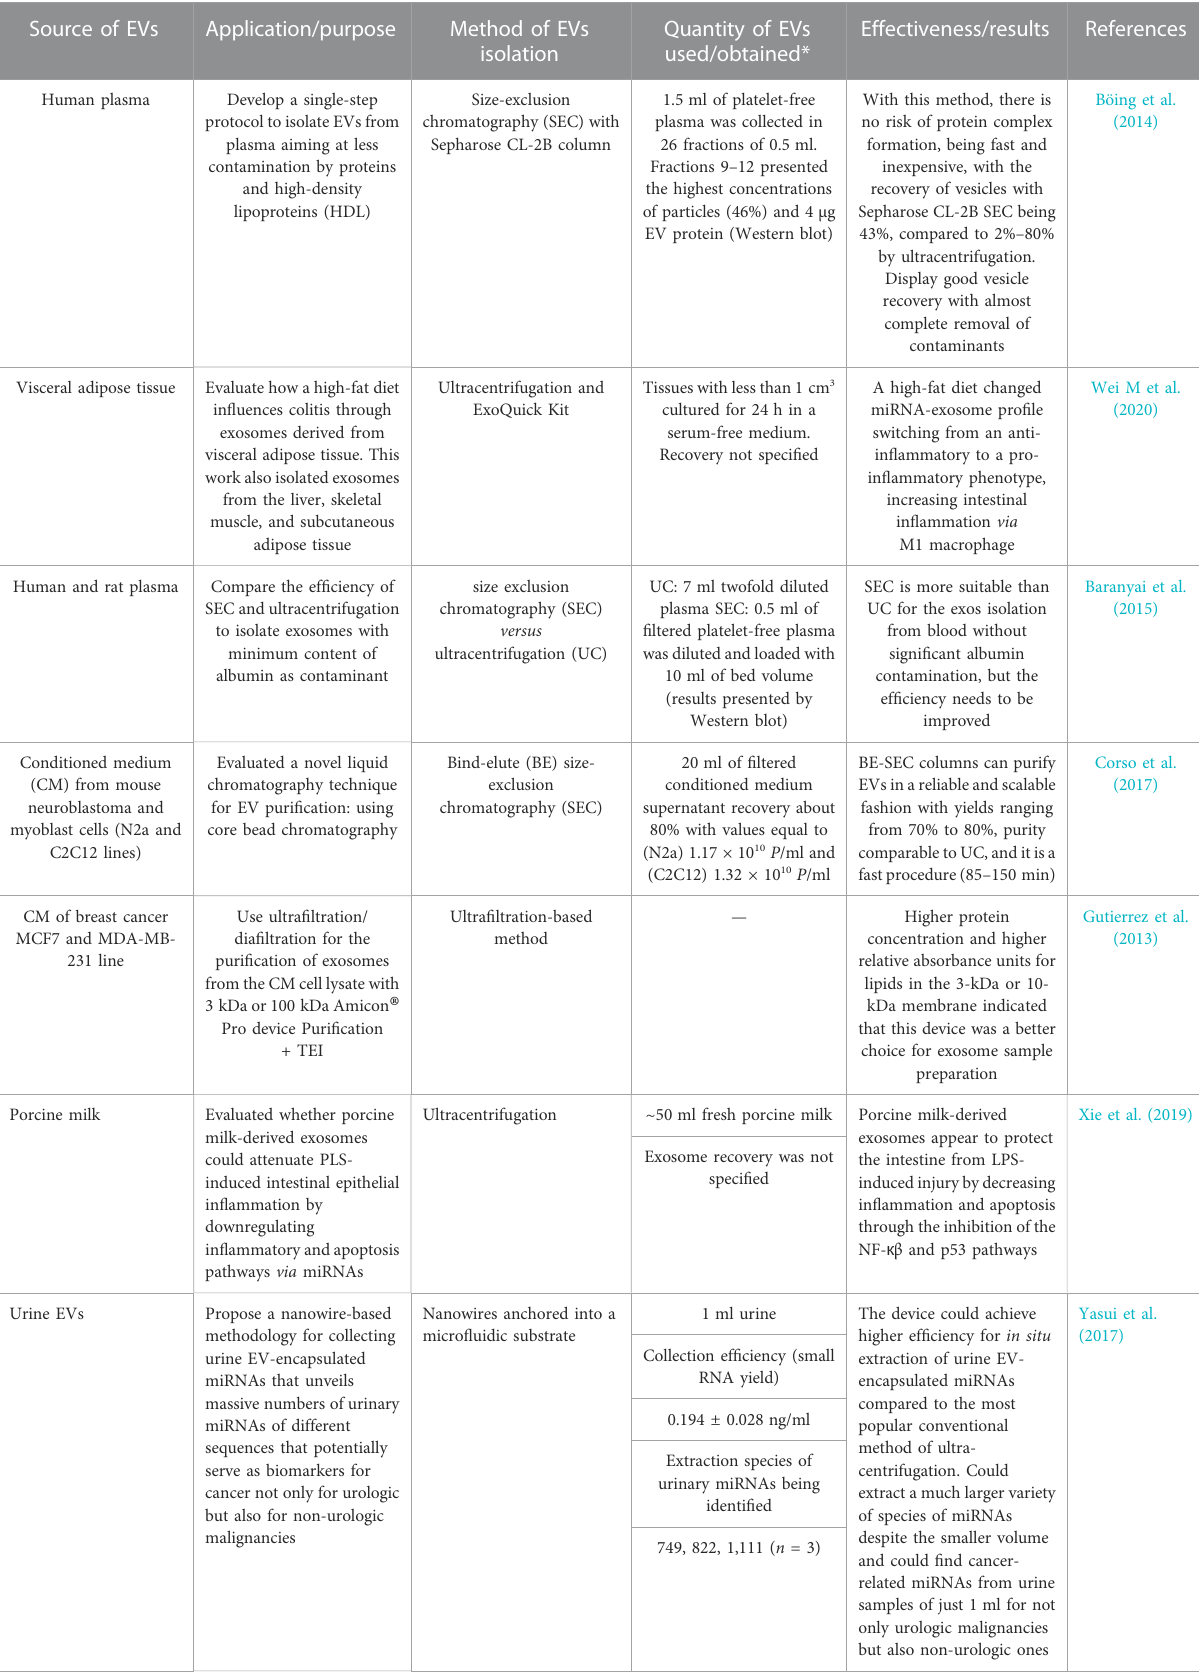
TABLE 1 Different sources used to isolate EVs, methods of isolation, and effectiveness of each